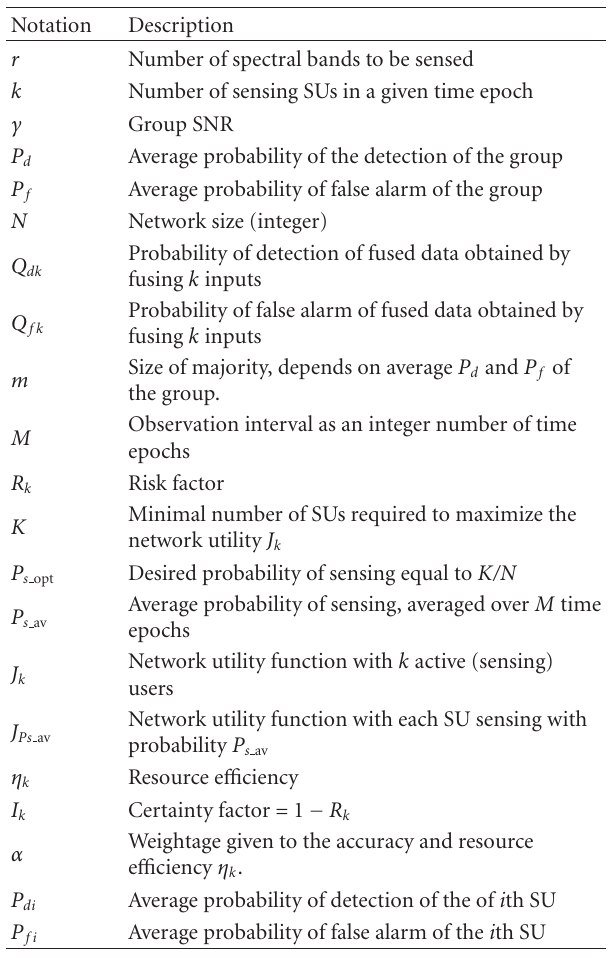
Table 1: Terminology